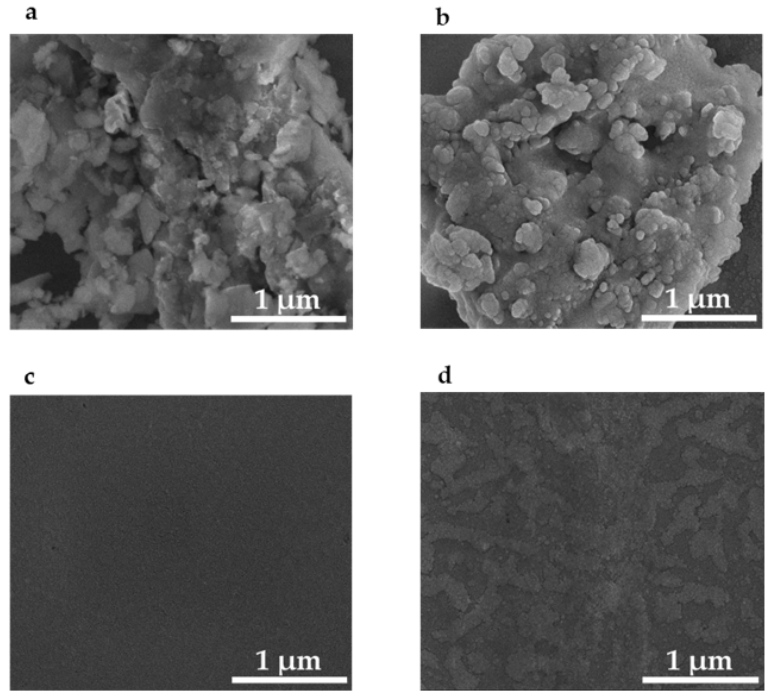
Figure 4. Scanning electron micrographs of: ( a ) 1 µ m grit sandpaper template; ( b ) silver nanoparticles assembled in the pits of PETE-1 thermoplastic imprinted with 1 µ m sandpaper; ( c ) non-imprinted and featureless PETE-1; ( d ) non-imprinted PETE-1 with few if any nanoparticles after drop-casting of the nanoparticle suspension.